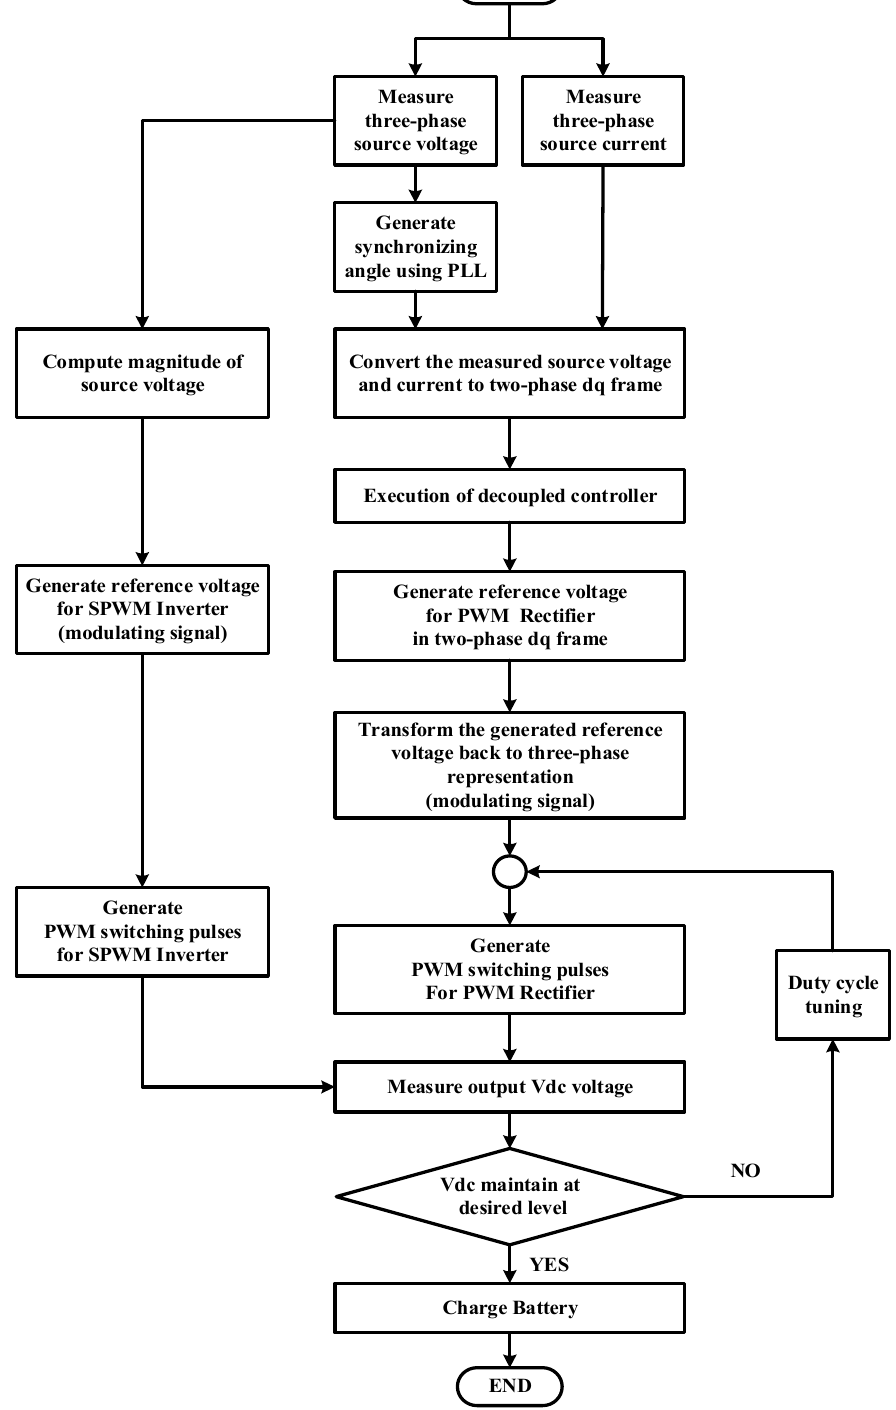
Figure 14. The procedure of implementation the EV fast charging prototype.